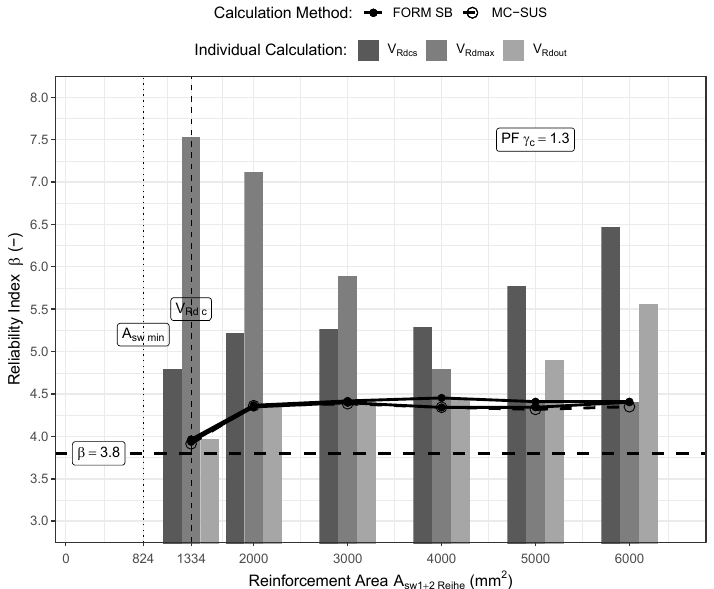
Figure 6 . Systems reliability analysis for a partial factor 𝛾 (cid:3004) of 1.3 . Figure 6. Systems reliability analysis for a partial factor γ